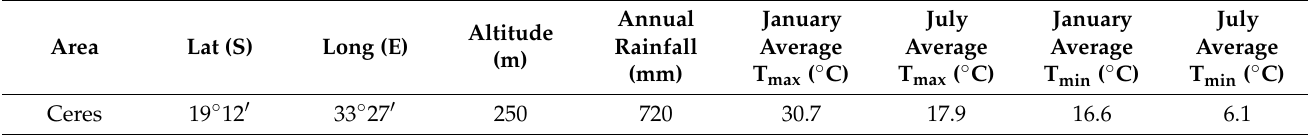
Table 2. Climate summary for Ceres for the period 1981–2010.